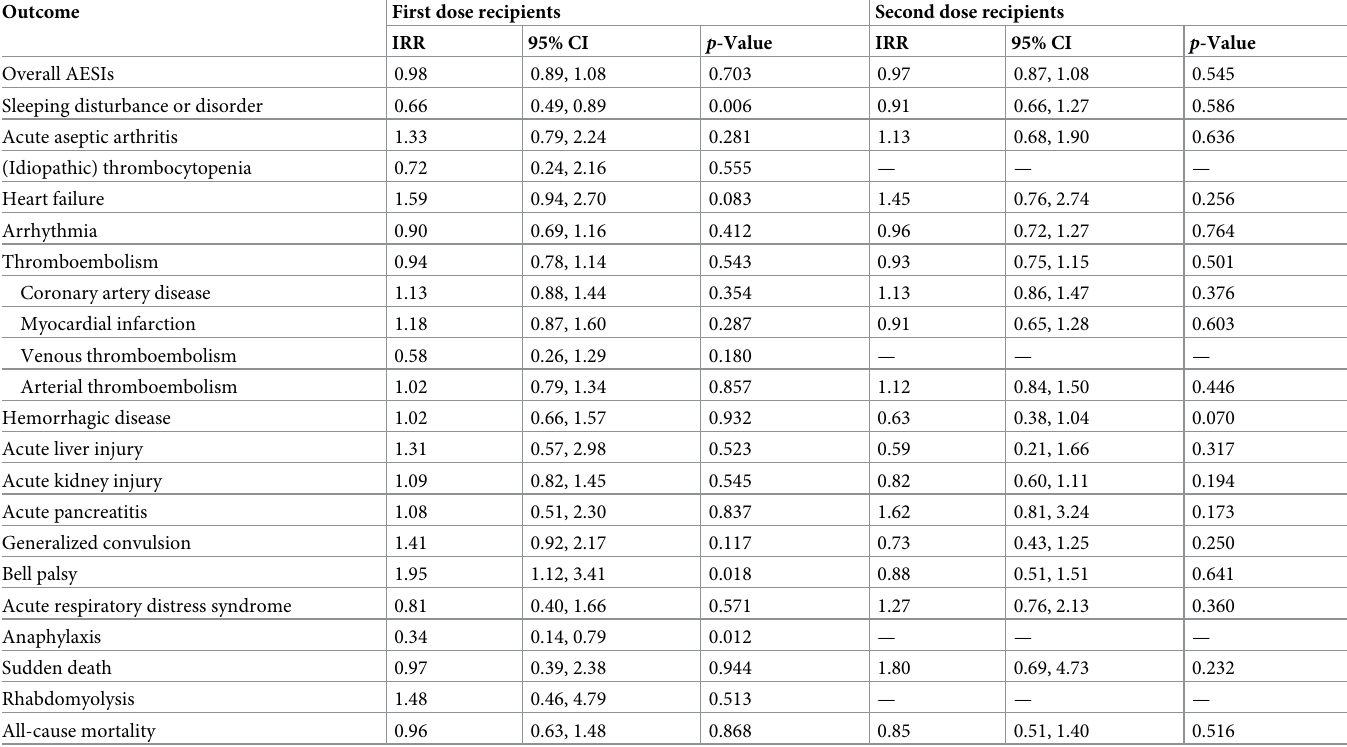
Table 3. Incidence rate ratio of AESIs among first dose and second dose recipients of CoronaVac versus BNT162b2 as the reference category (after weighting).